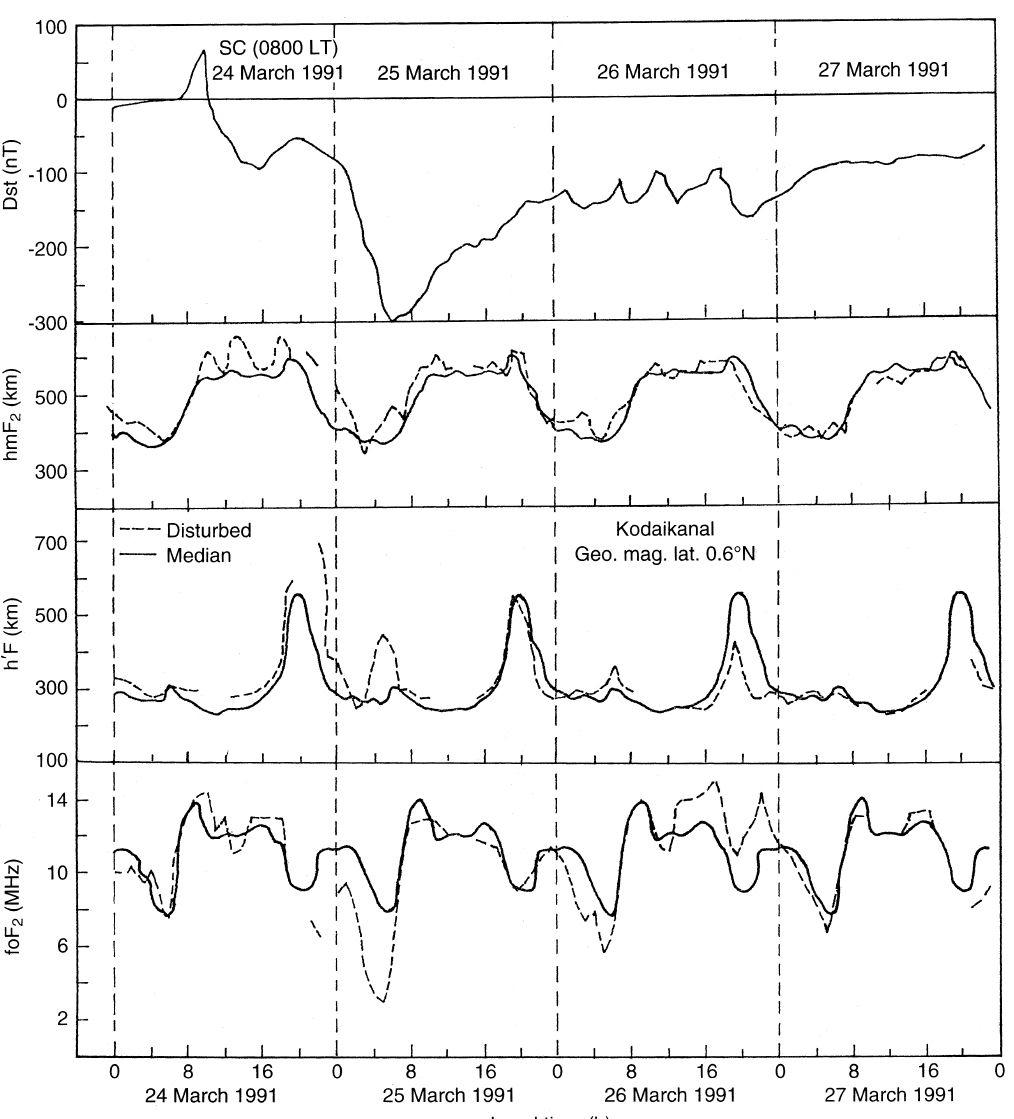
Fig. 1. Shows foF2, h ¢ F and hmF2 data for Kodaikanal for the 24 March 1991 storm along with respective monthly median values. Dst variation for the storm period is shown in the top